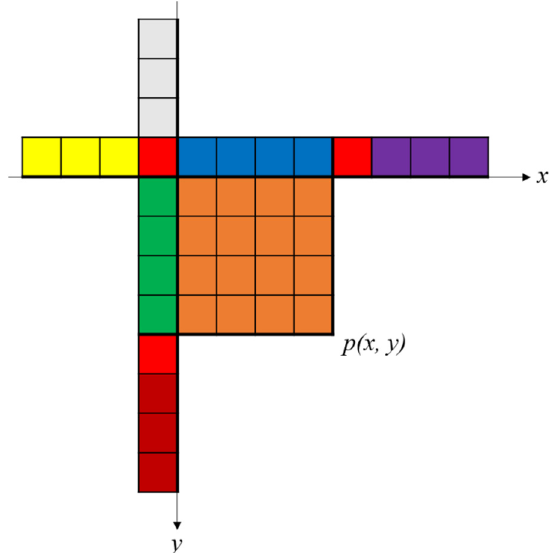
Figure 5. Possible reference samples that can be used in the proposed method.